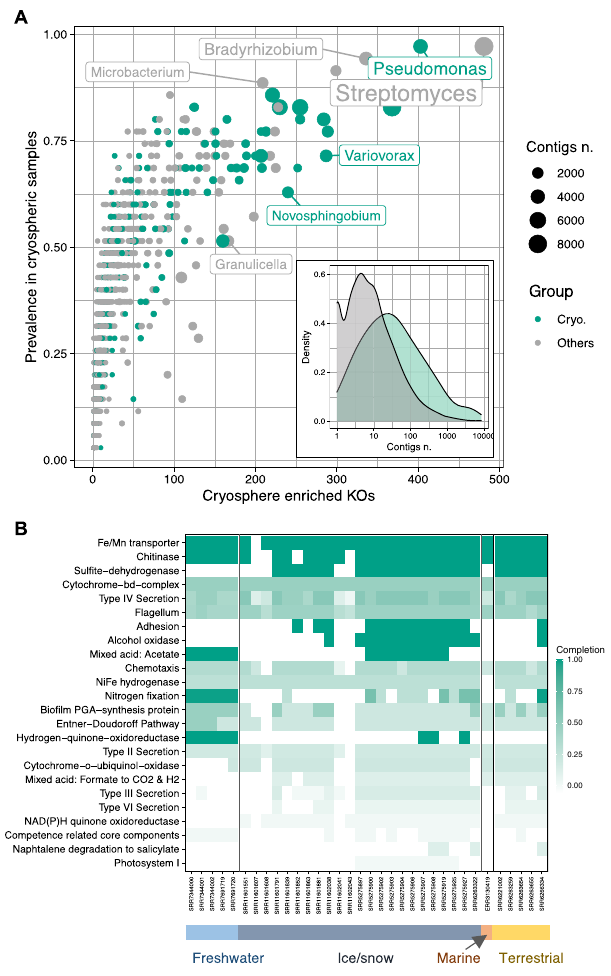
Fig. 4 Functional enrichment analysis and taxonomy of enriched functions. A Prevalence represented against the number of enriched KOs in cryospheric samples across bacterial genera. The shading represents the cryospheric and others bacterial genera whereas symbol size represents the number of contigs taxonomically assigned to the respective genus within cryospheric metagenomes. The insert represents the distribution of the number of contigs harbouring cryospheric enriched KOs across the cryospheric and others genera. B Heatmap representing the completion of pathways across cryospheric samples based only on the KOs enriched in the cryosphere. Source data are provided as a Source Data fi le.